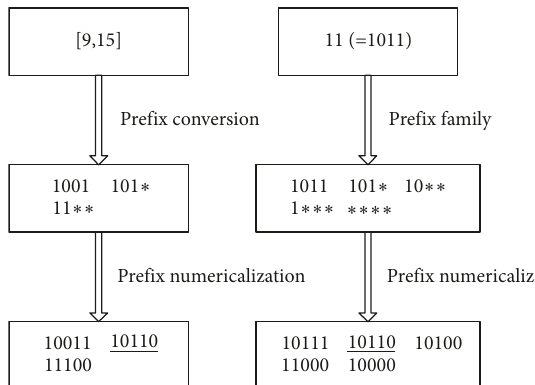
Figure 2: Prefix membership